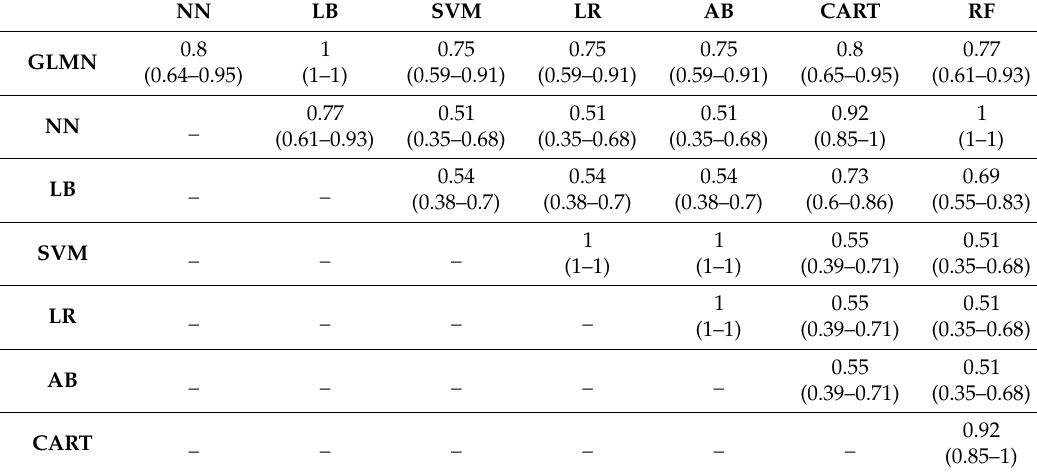
Table 5. Agreement between the class predicted by pair of machine learning techniques (MLTs) with complete case (CC) analysis. The values represent the point estimates of Cohen’s Kappa index along with their 95%